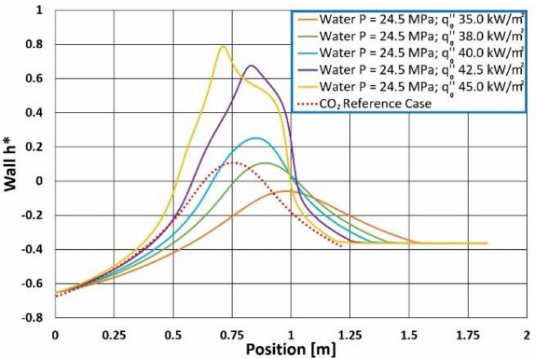
Figure 15. Wall h * trends for water at 24.50 MPa as a function of the axial position for a reference case with CO 2 , q 0 (cid:48)(cid:48) = 10 kW/m 2 and T in = 24 ◦ C.